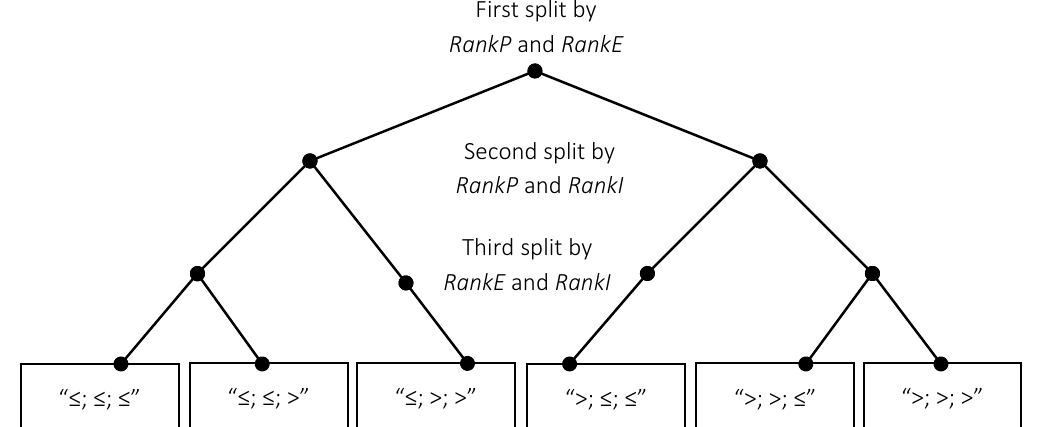
Figure 1. Pruned tree of divisive hierarchical